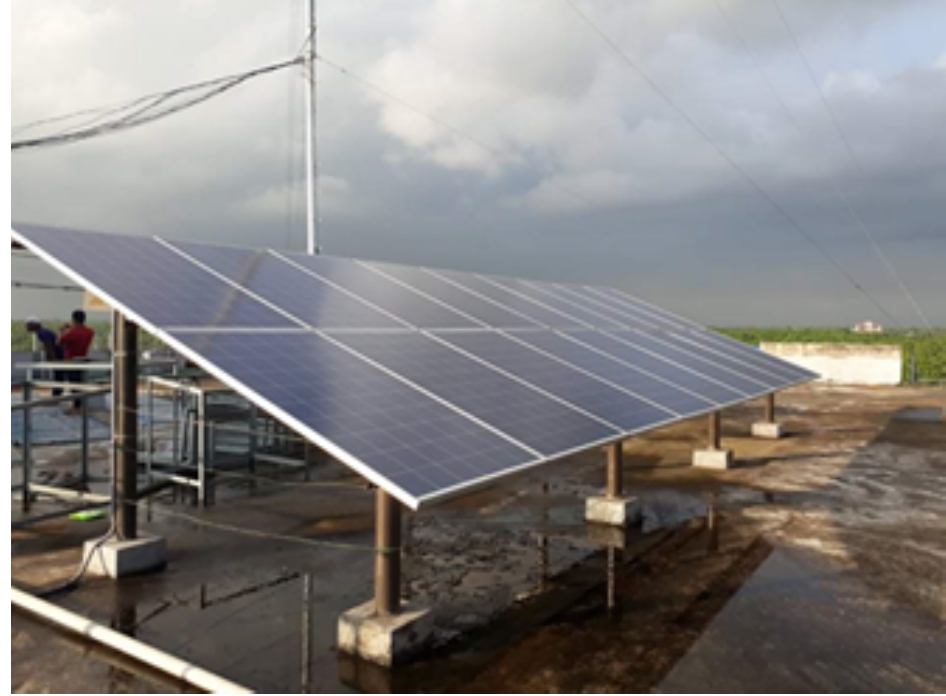
Figure 6. Picture of the solar PV array installed at the roof of Niagara